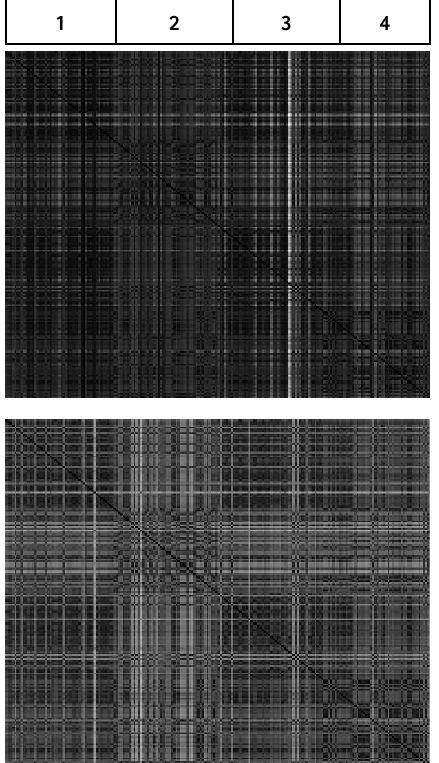
Figure 3. (Top) RMSE band of square array image; (Bottom) spectral angle band of square array image